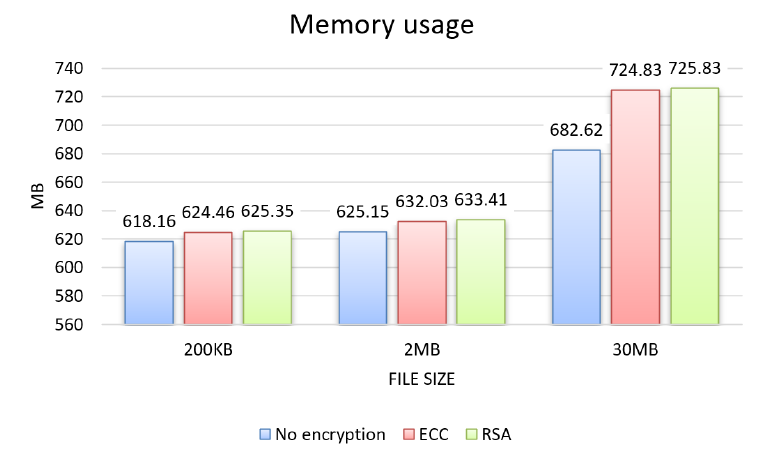
Figure 5. Memory usage.